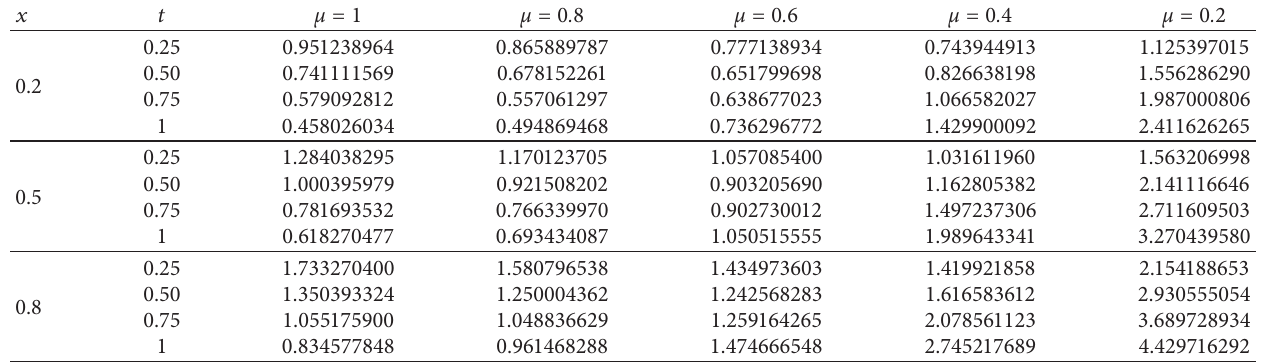
Table 2: Numerical values for v ( t , x ) of equation (28) for different values of t and x .